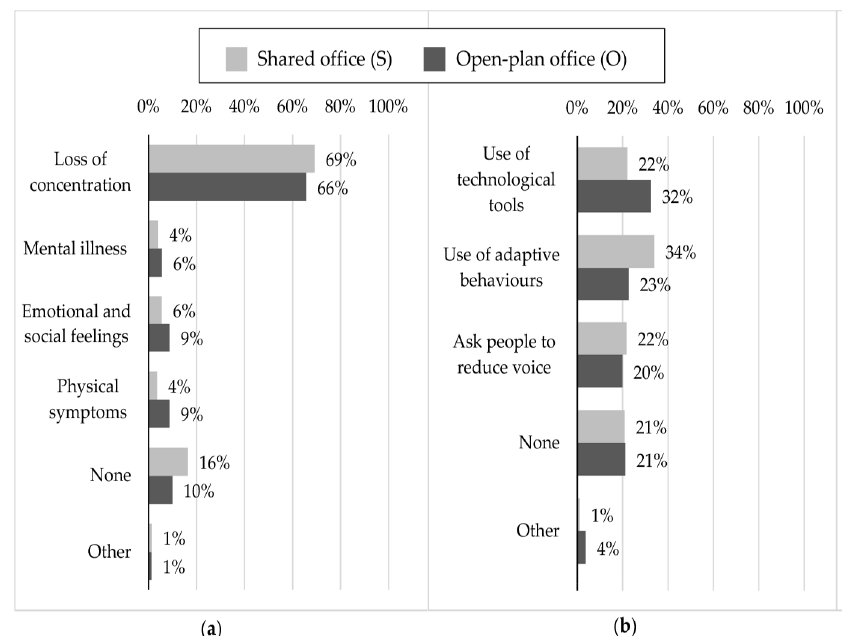
Figure 1. Percentages related to the effects of ISN on mental health and well-being, and occupants’ behavior in shared (S) and open-plan (O) offices: ( a ) Subjective ratings on feelings and symptoms attributed by occupants to ISN; ( b ) Subjective ratings on personal strategies used by occupants to cope with ISN.